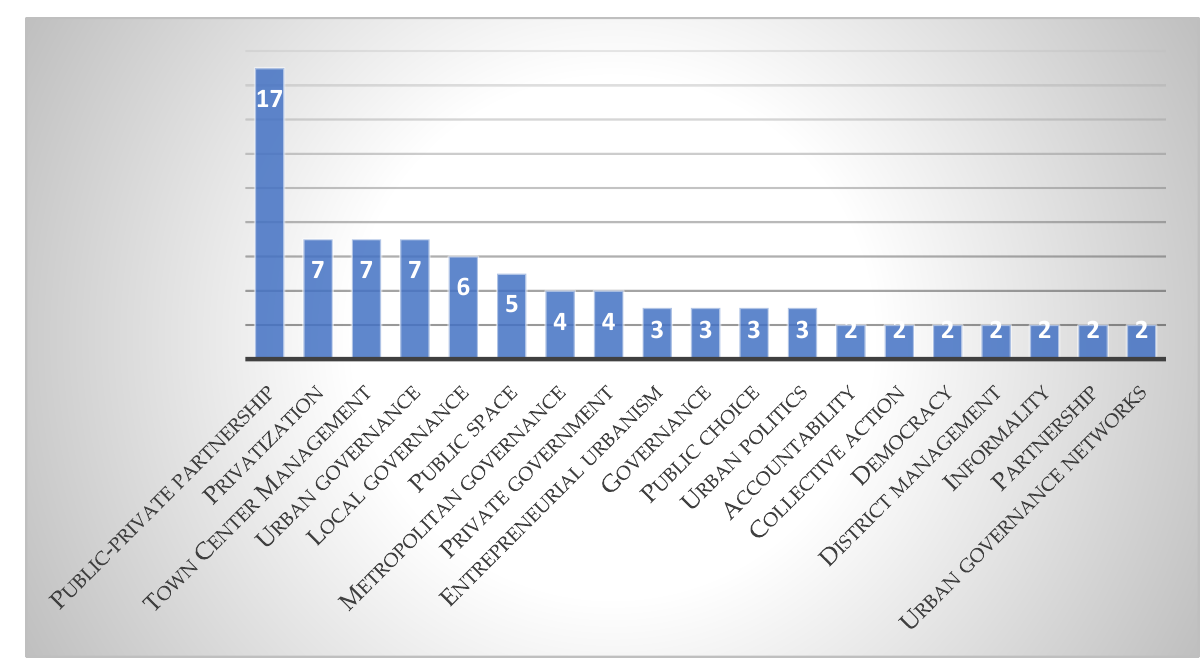
Figure 4. Word cloud extracted from keywords that fit the dimension “Urban Governance”.